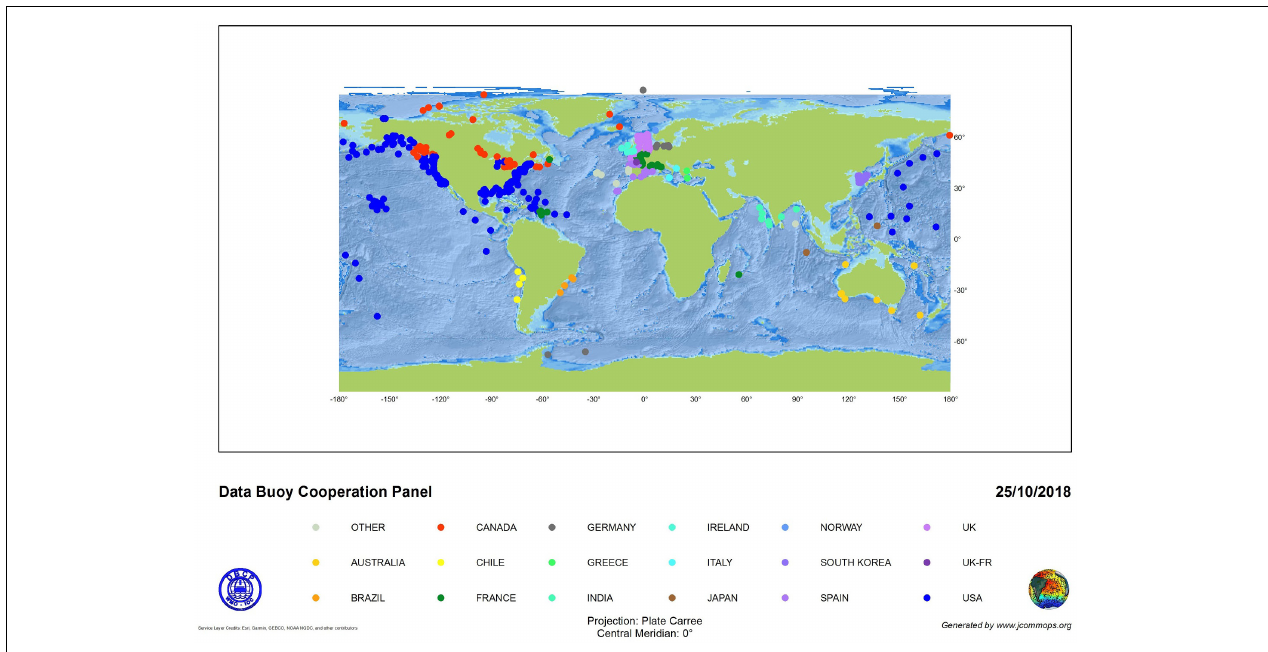
FIGURE 2 | Operational coastal moorings that are coordinated by the Data Buoy Cooperation Panel, as of October 2018. Source: